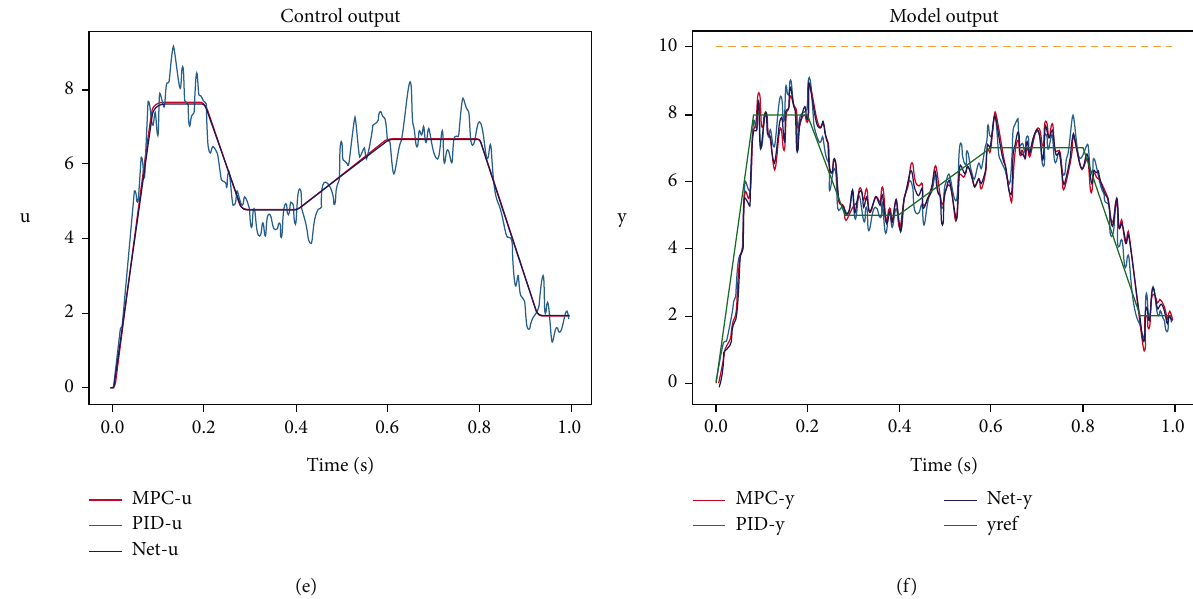
Figure 10: The control process of di ff erent controllers under the same conditions. (a – f) The predictive input u and plant output y under the control of MPC, designed network, and PID from 0 to 1 s. (a, c, and e) The trajectories of u , and (b, d, and f) the trajectories of the reference output y ref , noise ξ , and plant output y